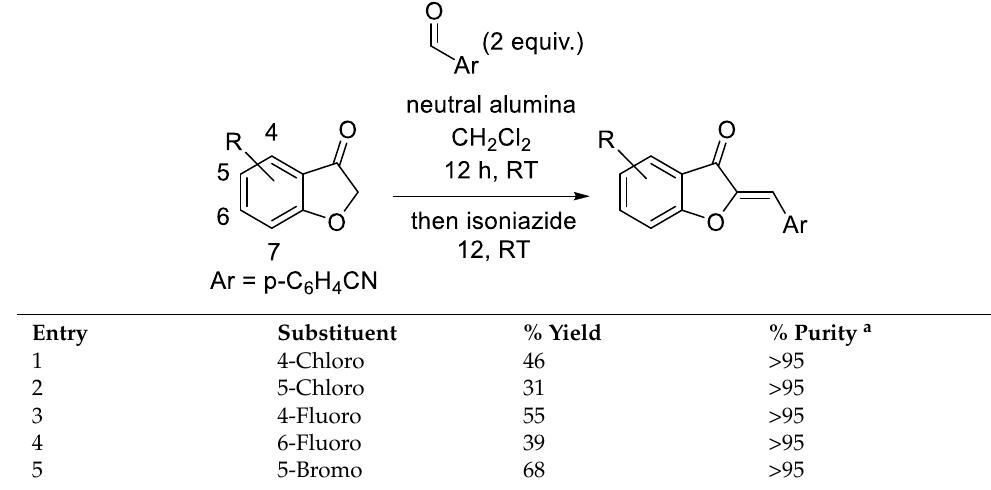
Table 3. Variations in benzofuranone using isoniazid as the scavenger.